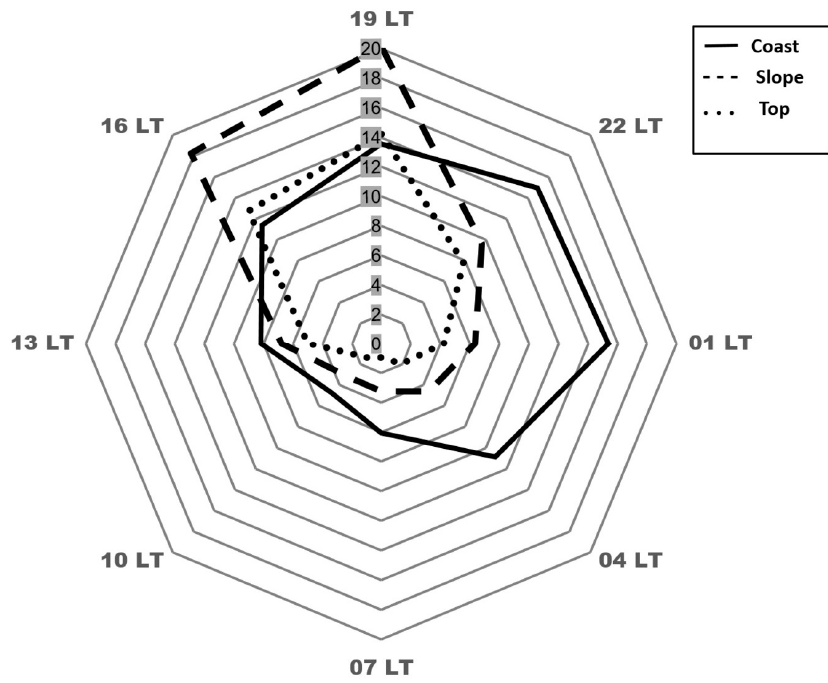
Figure 7. Diurnal variation of precipitation (mm h − 1 ) for the coastal plain (0–500 m.a.s.l.), the slope (500–2000 m.a.s.l.) and the top of the mountains ( > 2000 m.a.s.l.), using CMORPH precipitation data (1998–2015) for summer (May–October). The inside scale shows the rainfall values and outside scale is the local time.